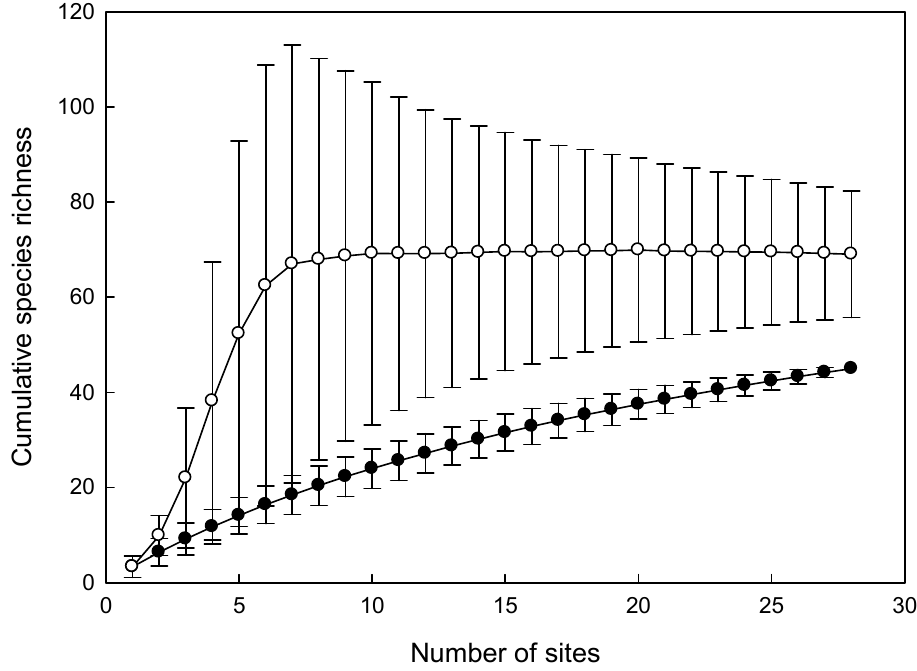
Figure 2. Species accumulation curves showing the average observed (closed circles) and cumulative taxa richness estimated by the Chao 2 index (open circles) against the number of 28 sites of living material. Whiskers display 1 × SD (standard deviation).